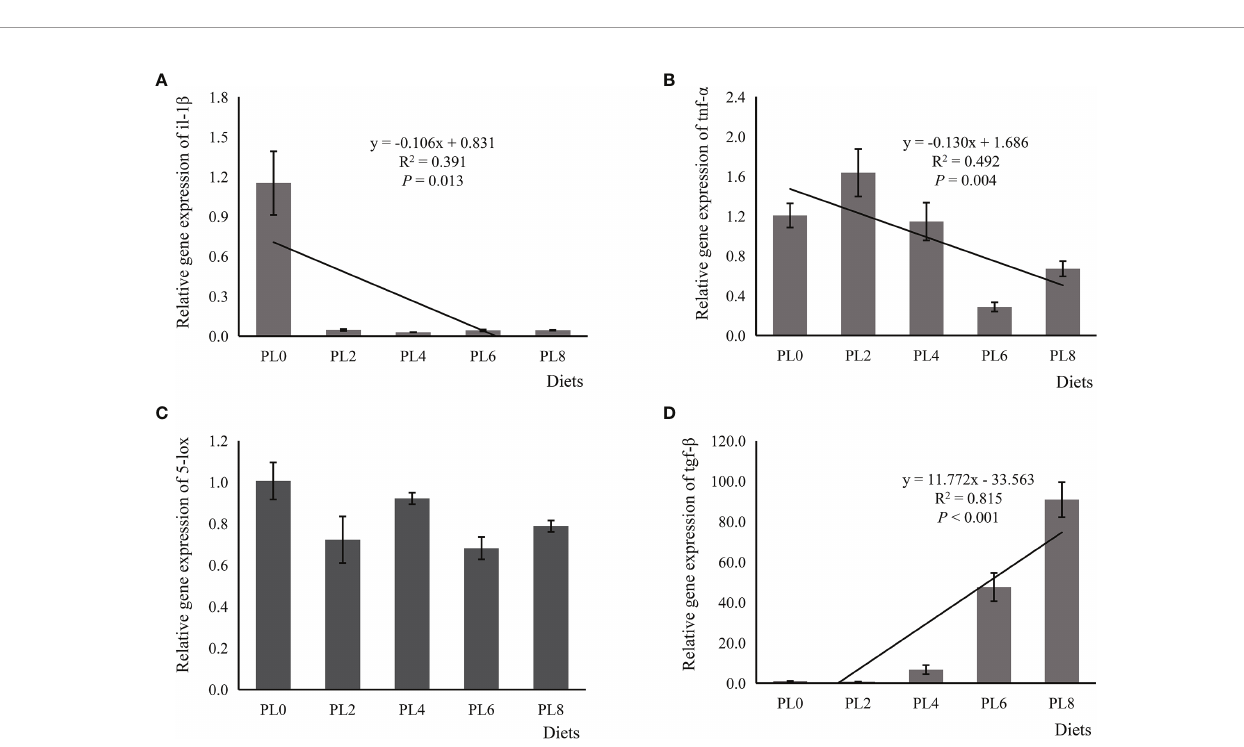
FIGURE 5 | Relative expression of pro-in fl ammatory, including interleukin-1 b (il-1 b ) (A) , tumor necrosis factor- a (tnf- a ) (B) , and 5-lipoxygenase (5-lox) (C) , and anti- in fl ammatory transforming growth factor- b (tgf- b ) (D) in intestine of larval largemouth bass fed diets with graded levels of phospholipids for 28 days. il-1 b : P linear = 0.013, R 2 linear = 0.391; P quadratic = 0.001, R 2 quadratic = 0.695; tnf- a : P linear = 0.004, R 2 linear = 0.492; P quadratic = 0.017, R 2 quadratic = 0.493; 5-lox: P linear = 0.132, R 2 linear = 0.166; P quadratic = 0.239, R 2 quadratic = 0.212; tgf- b : P linear = 0.000, R 2 linear = 0.815; P quadratic < 0.000, R 2 quadratic = 0.956. The “ x ” in the regression equation means the variation of dietary phospholipids